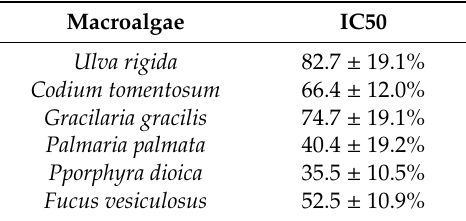
Table 4. Polar lipid extract concentration ( µ g / mL] that induced 50% inhibition (IC50) of MDA-MB-231 cells. Values are means of three assays ± standard